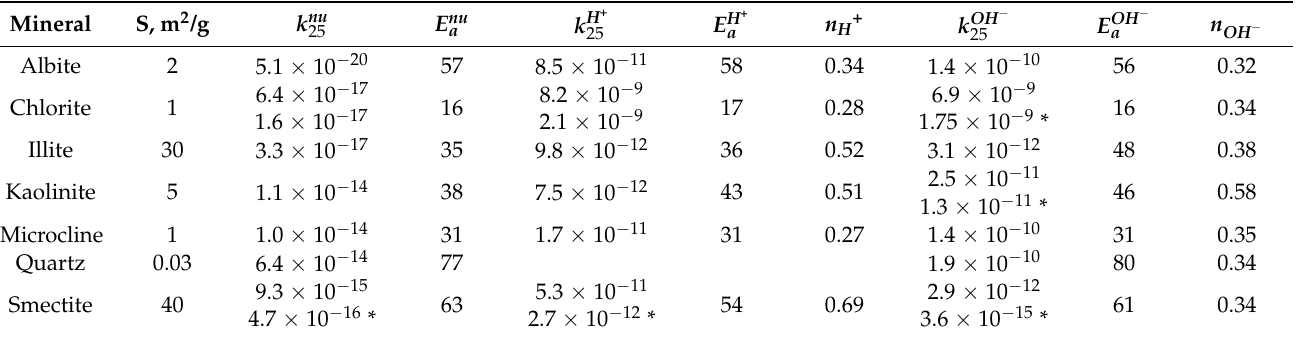
Figure 10. Modeling results: ( a ) Comparison of model and experimental data of clay phases evolution. Lines—modeling; squares—experimental data. ( b ) Model of the evolution of bentonite from the 10th Khutor deposit in this system for 450 days. Table 8. Parameters for the dissolution rate model. The kinetic constant ( k ) is given in mol · m − 2 · s − 1 and the activation energy ( E a ) is given in kJ · mol − 1 (according to [65] and calibration *) in Equation